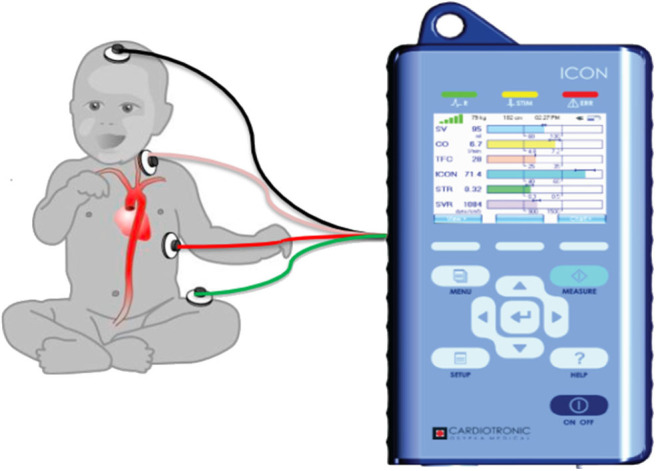
Figure shows the placement of the electrodes on the left side of the body connected to the ICON monitor. Adopted from Icon user manual with due permission from Markus Osypka, Osypka Medical Inc, Germany.